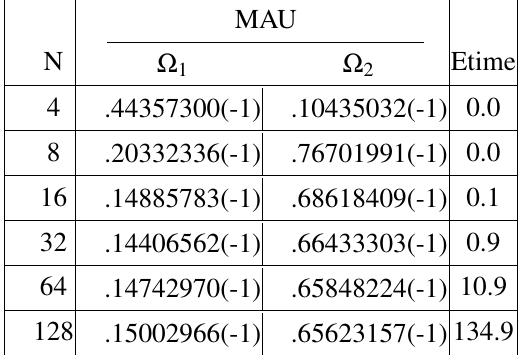
Table 1 Maximum absolute errors in u ( x , y ) in Ω 1 and Ω 2 for problem